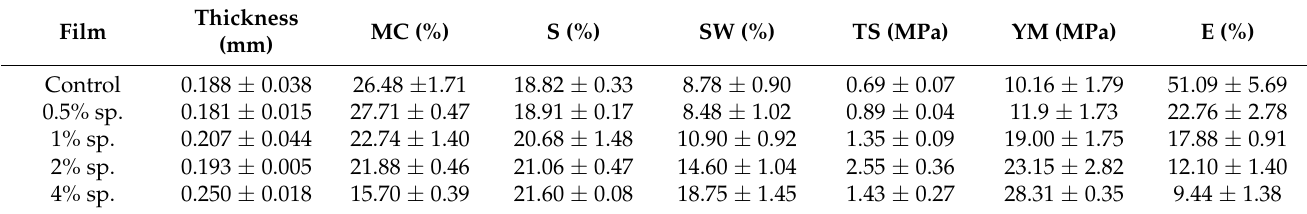
Table 1. The influence of addition of sp. on the water properties and mechanical properties of WPC films. Values (average ± standard deviation) of moisture content (MC), solubility (S), swelling degree (SW), tensile strength (TS), Young’s modulus (YM) and elongation at break